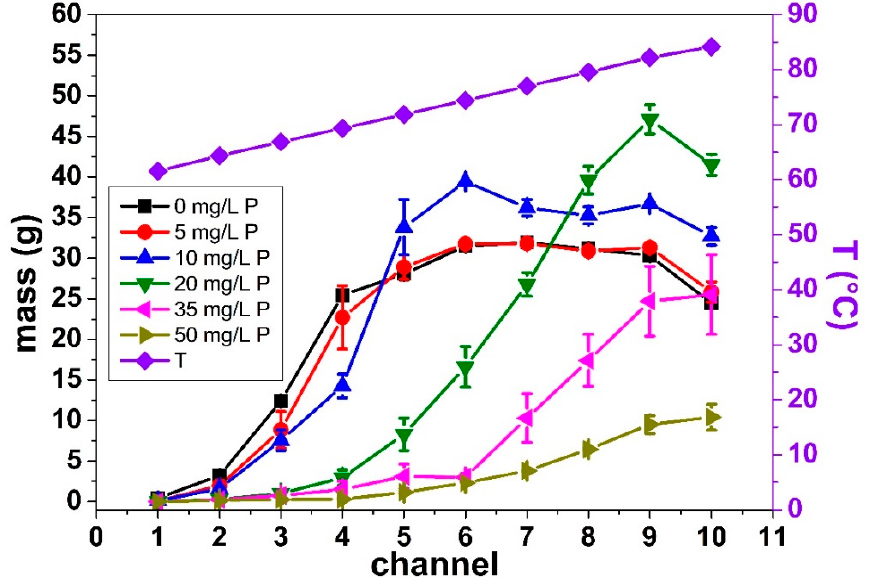
Figure 4. Dry deposit mass per channel along the PHE for all P concentrations and the temperature profile in the heating zone. The model fluid was a 0.5% ( w / v ) WPI solution with an average calcium concentration equal to <[Ca]> = 101.02 ± 2.06 mg/L.